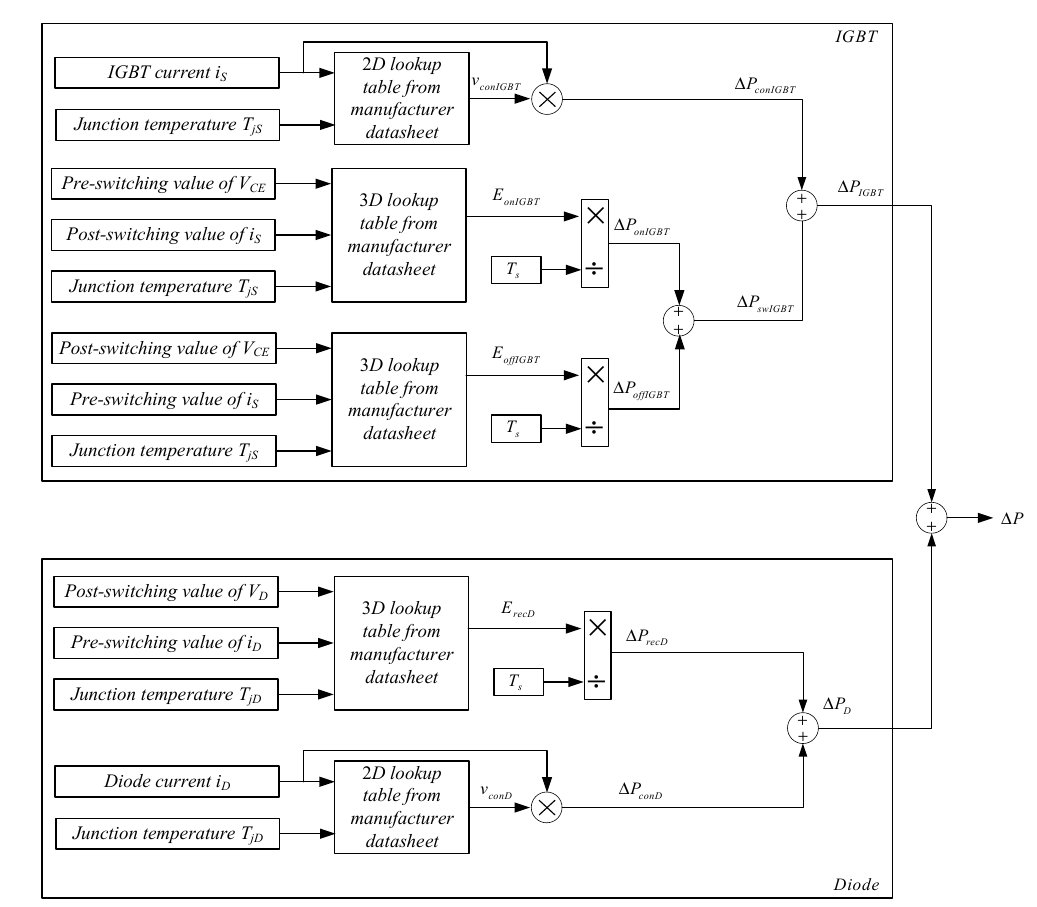
Figure 3. Loss calculation procedure for each insulated gate bipolar transistor (IGBT)/Diode switch.